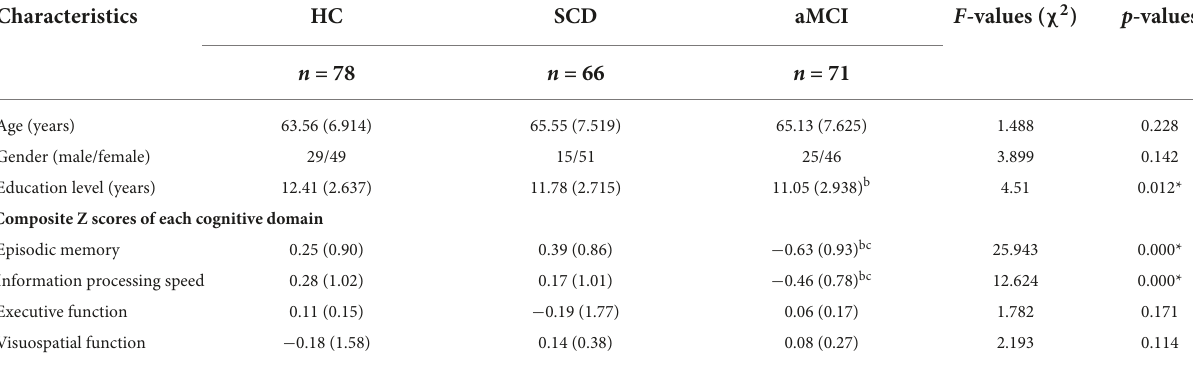
TABLE 2 Demographics and clinical measures of healthy control (HC) and patients with subjective cognitive decline (SCD), and amnestic mild cognitive impairment (aMCI).